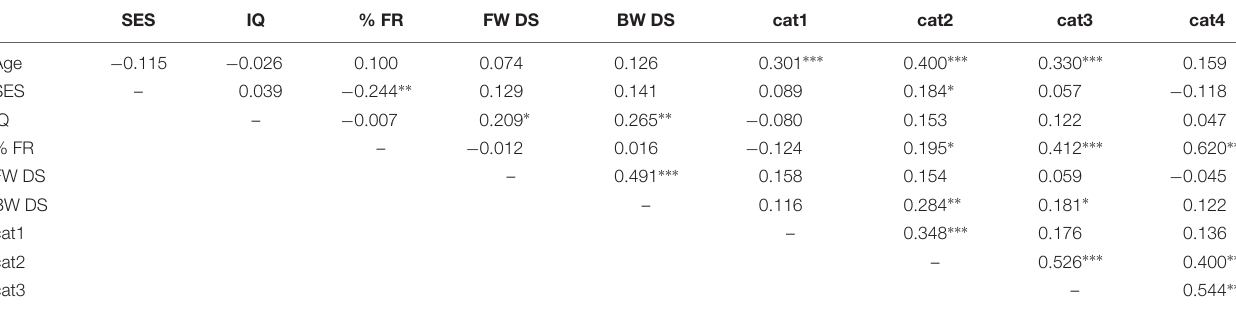
TABLE | Bivariate correlations among all variables at Time 2.